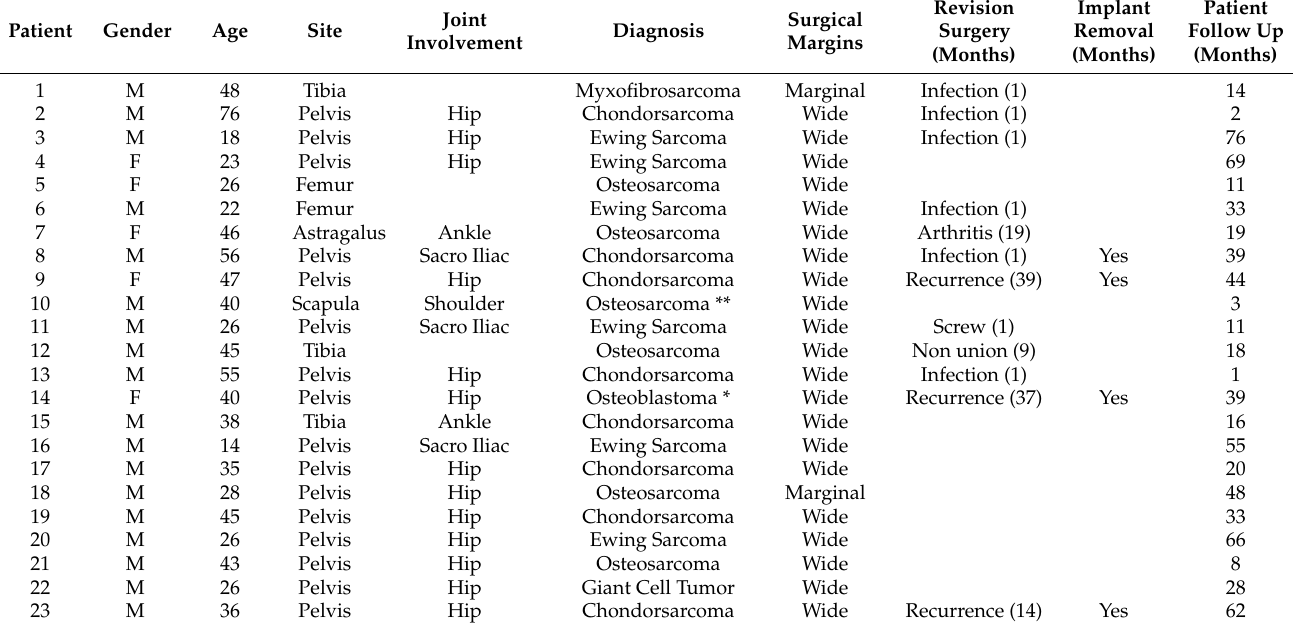
Table 1. Demographics, surgical details, complications and follow up of 23 3D/PSI custom implants; * benign tumour ** low-grade malignant